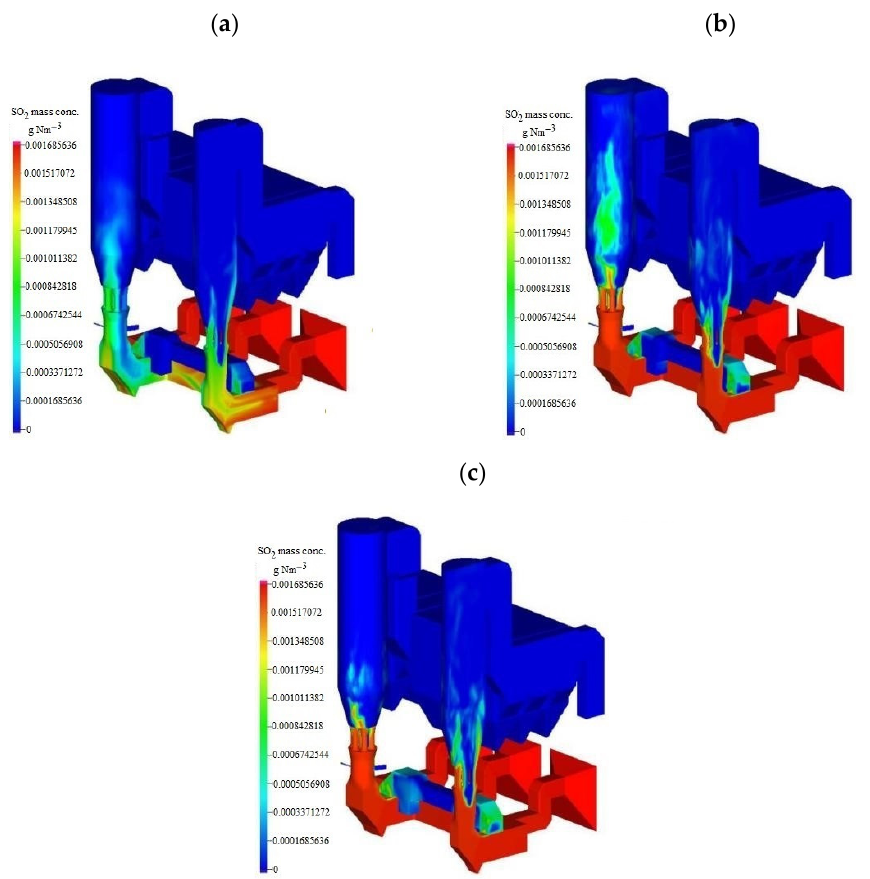
Figure 5. Distribution of SO 2 mass concentration in the tower at different times. ( a ) t = 5 s ( b ) t = 10 s ( c ) t =15 s.